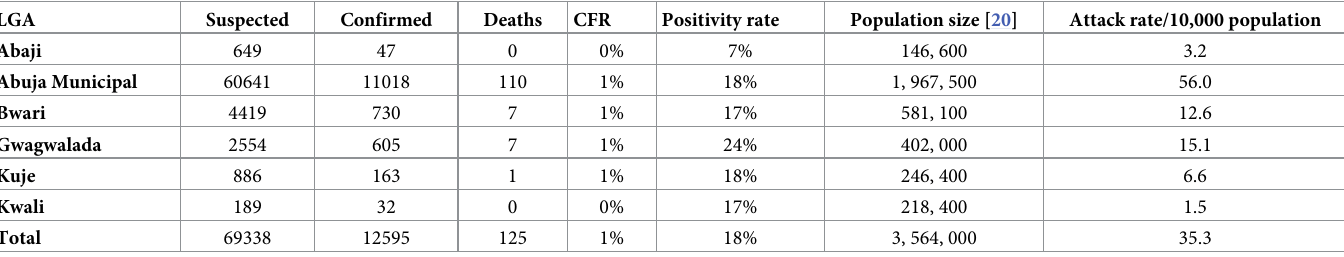
Table 1. Distribution of confirmed COVID-19 cases in FCT by LGA from March 2020 –January 2021.